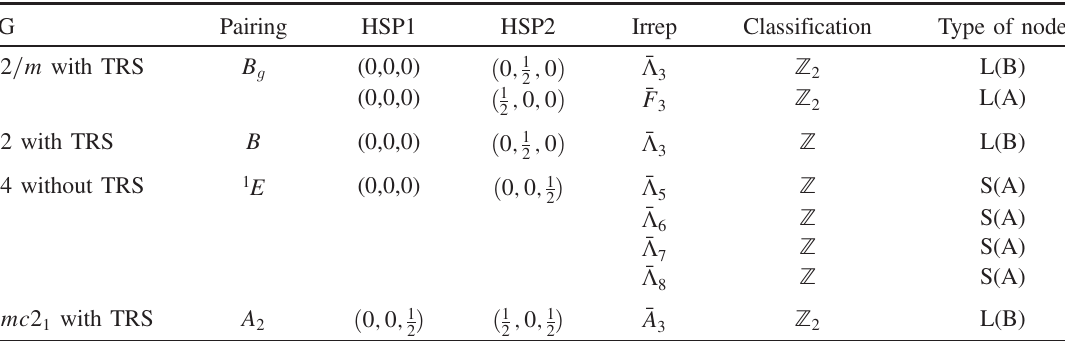
TABLE VII. Summary of classification results for examples discussed in this work. Space groups and pairing symmetries are shown in the first and second columns. The third and fourth ones represent the boundary points of the line where a gapless point exists. The fifth column is the label of an irreducible representation (irrep), which follows the notation in Ref. [104]. The sixth column shows the classification Z or Z 2 , and the seventh column means the type of nodes. Here P, L, and S denote point, line, and surface nodes, respectively. In addition, while (A) means that the shape of the node is determined only by compatibility conditions, (B) indicates that gapless point classifications are